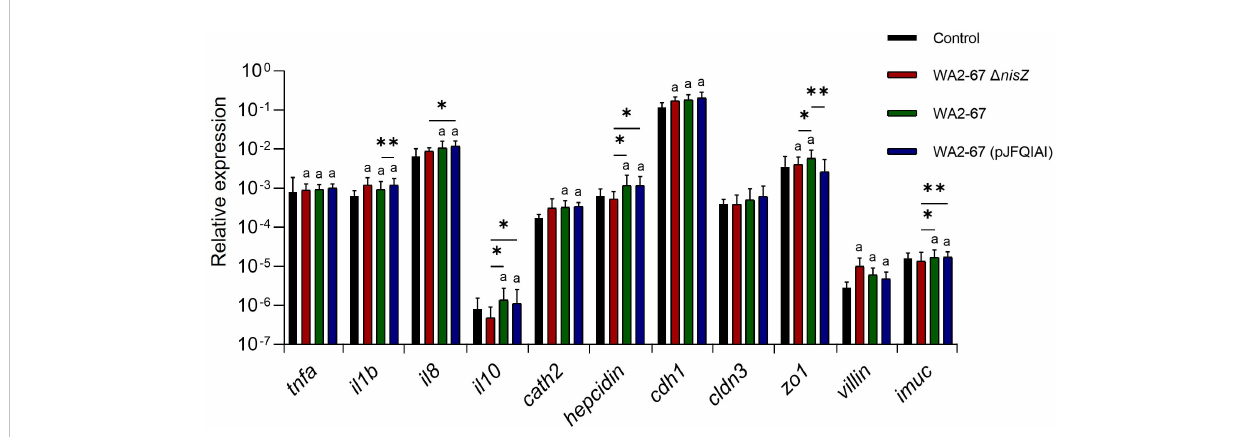
FIGURE 1 Transcriptional response of RTgutGC cells to different LAB strains: L. cremoris WA2-67 D nisZ , L. cremoris WA2-67 and L. cremoris WA2-67 (pJFQIAI). RTgutGC cells were incubated with 1 x 10 6 cfu/ml of each bacterial strain at 20°C for 24 h. Subsequently, RNA was extracted and the levels of transcription of different genes analyzed by real-time PCR. Relative gene expression levels were normalized to the transcription of the housekeeping gene ef1a . Data are shown as mean fold change + SD (n = 8). The letter (a) represents transcription levels signi fi cantly different than those observed in cells not exposed to bacterial strains (control), while the asterisks indicate levels signi fi cantly different between bacterial treatments as indicated (* p ≤ 0.05 and ** p ≤ 0.01).